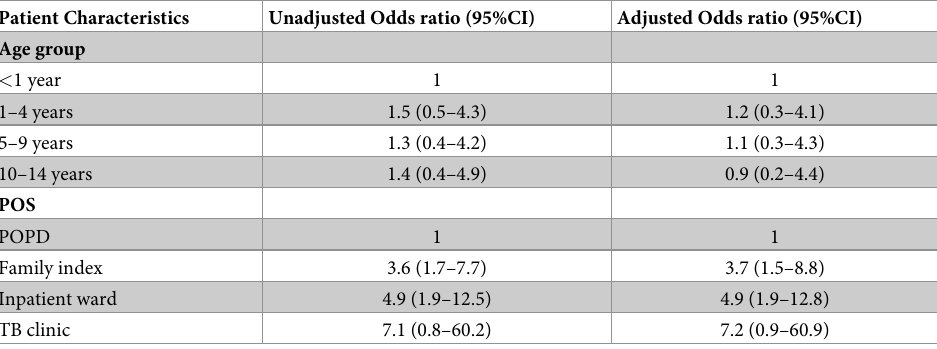
Table 3. Unadjusted and adjusted odds ratios of pediatric HIV case detection by patient age group and